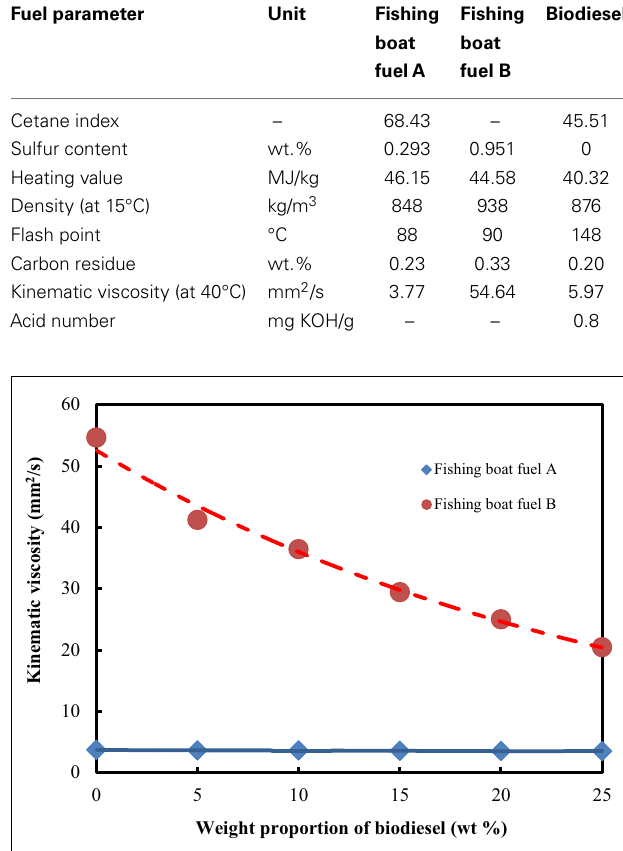
FIGURE 1 |Variation in kinematic viscosity according to the weight proportion of biodiesel-blended in fishing boat fuelsA and B .